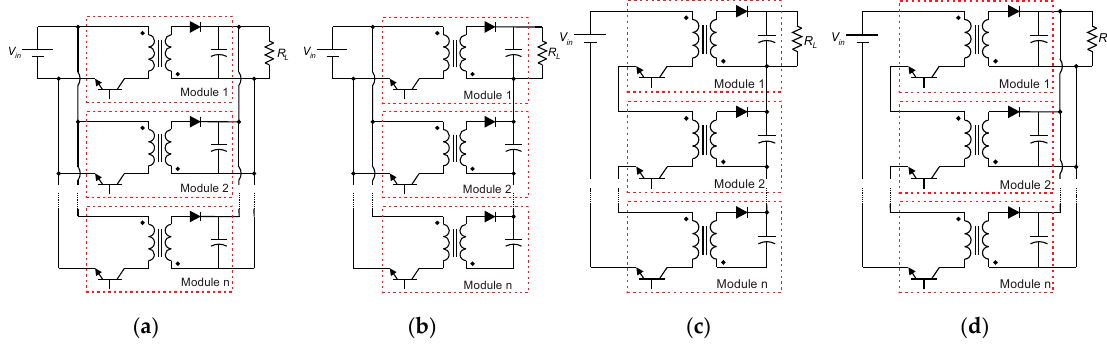
Figure 1. Architectures of modular flyback converters: ( a ) IPOP, ( b ) IPOS, ( c ) ISOS, ( d ) ISOP.